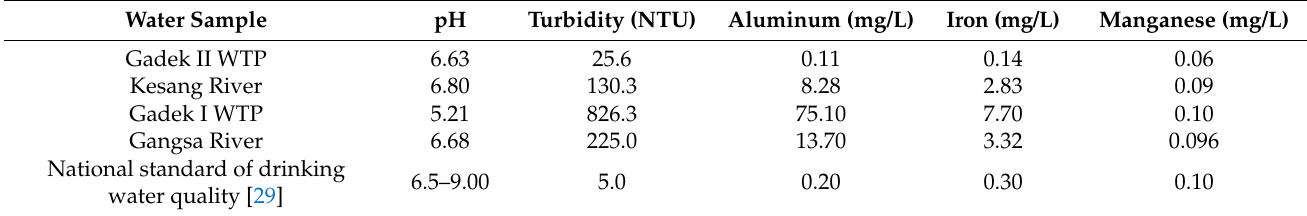
Table 1. Water samples and their